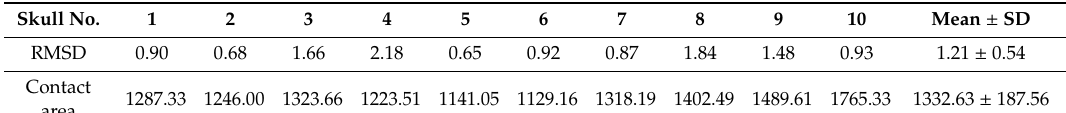
Table 2. Root mean square deviation between the planned and actual positions for the reference structures of the surgical template (mm) and the contact area between the template and the underlying bone (mm 2 ).